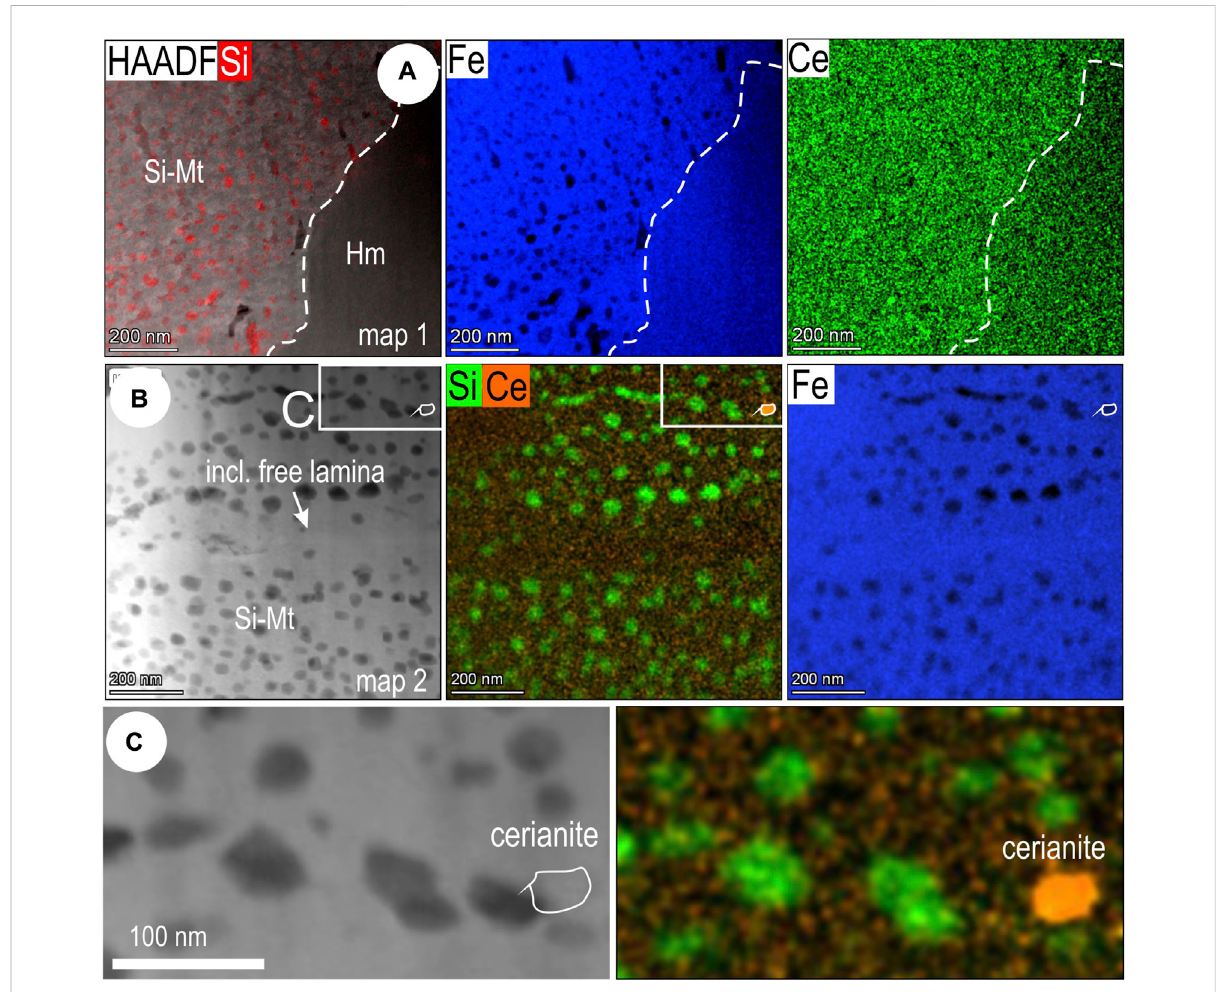
FIGURE 5 (A) HAADF STEM image with Si overlay (left) and STEM EDS element maps for Fe and Ce across silician magnetite (Si-Mt) — hematite (Hm) boundary(foil Mt#2). Notethat Ce is slightly higher insilician magnetitecompared to hematite (interpreted as martite). (B) HAADF STEM image(left), overlay of Si and Ce element maps and Fe map showing banding with respect to silician NPs (Si-Fe NPs) in silician magnetite (Si-Mt) from foil Mt#3. Noteinclusion-freelaminainthemiddle. (C) Enlargementofareaindicatedbywhiteboxin (B) ,showingthepresenceofacerianiteNPalongthe Si-Fe NP